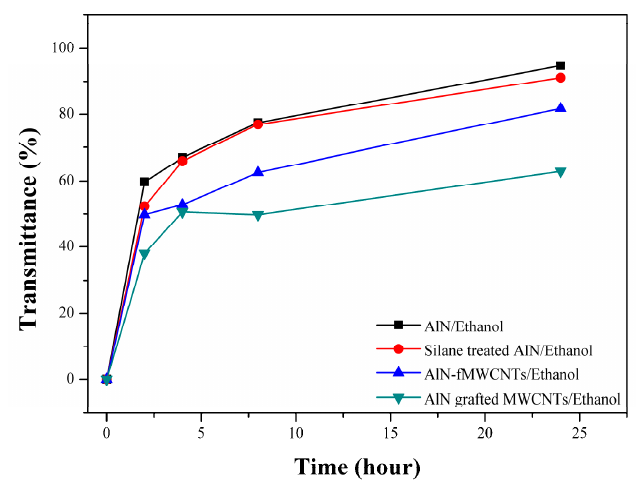
Figure 4. UV–Visible transmittances of the MWCNTs/AlN in ethanol depending on the time.